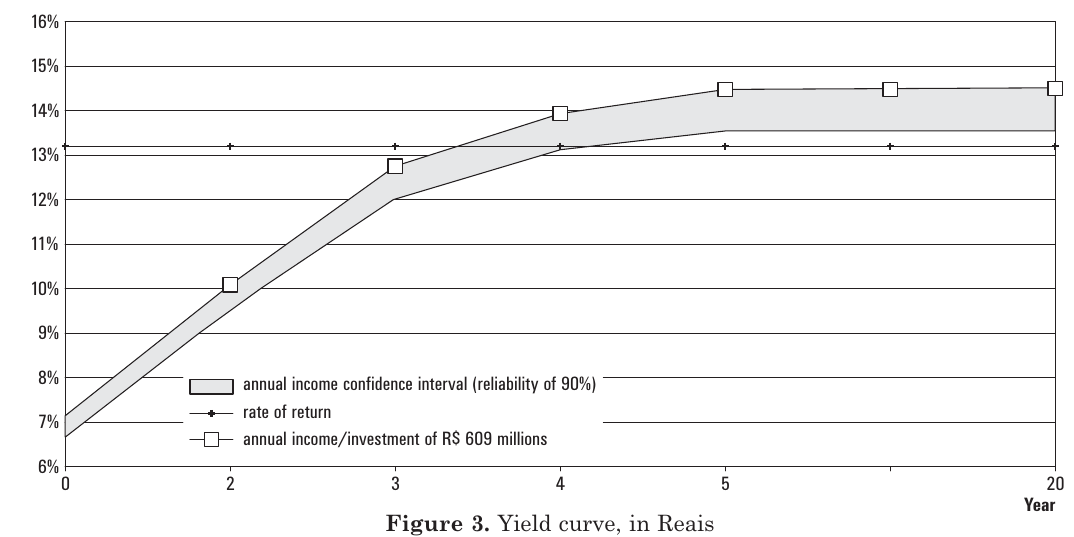
Figure 3. Yield curve, in